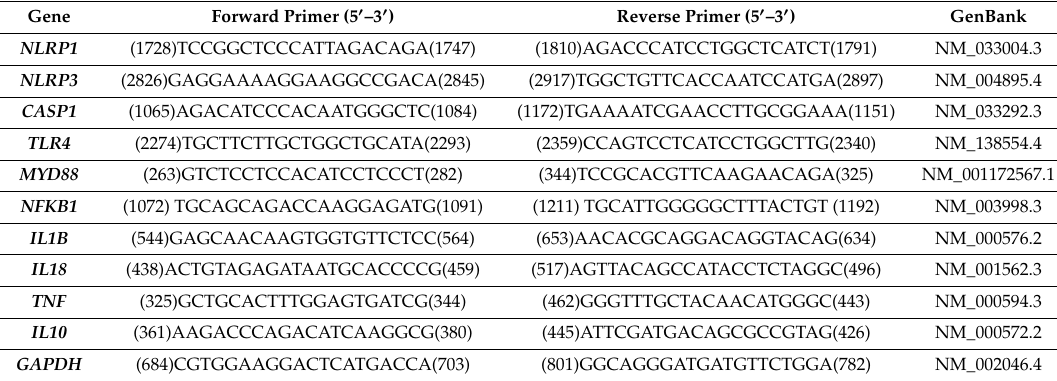
Table 2. Primers for inflammasome and NF- κ B pathway components, cytokines and GAPDH . Numbers indicate nucleotide positions in the corresponding